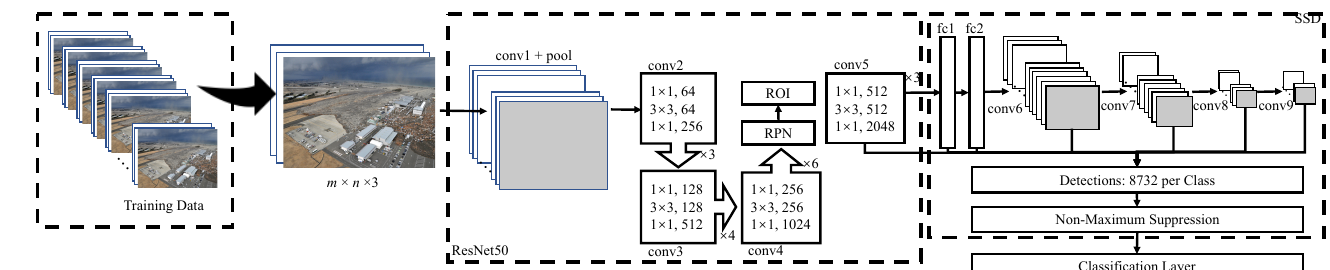
Figure 5. Modified SSD network ResNet-50.